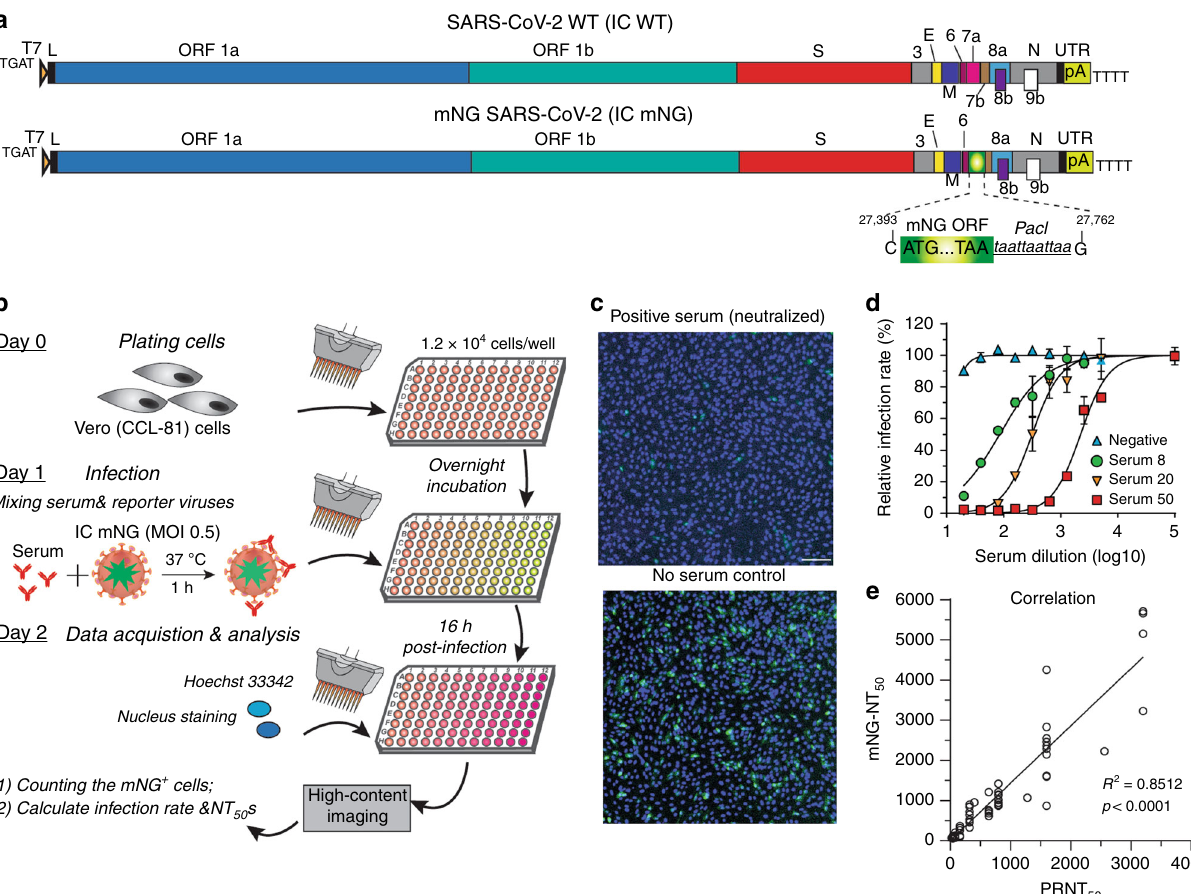
Fig. 1 A high-throughput neutralizing antibody assay for COVID-19 diagnosis. a Diagram of the cDNA constructs of wild-type (WT) SARS-CoV-2 (top panel) and mNG SARS-CoV-2 (bottom panel). The nucleotide positions of viral genome where mNG is engineered are indicated. b Assay fl owchart. mNG SARS-CoV-2 was neutralized with COVID-19 patient sera. Vero CCL-81 cells were infected with the reporter virus/serum mixture with an MOI of 0.5. The fl uorescence of infected cells was quanti fi ed to estimate the NT 50 value for each serum. c Representative images of reporter virus-infected Vero CCL-81 cells. Images for a positive neutralizing serum (top panel) and no serum control (bottom panel) are presented. Scale bar, 100 μ m. d Neutralization curves. Representative neutralization curves are presented for three positive sera and one negative sera. The means and standard deviations from two independent experiments are presented. e Correlation analysis of NT 50 values between the reporter virus and PRNT assays. The Pearson correlation ef fi ciency R 2 and p- value (two-tailed) are